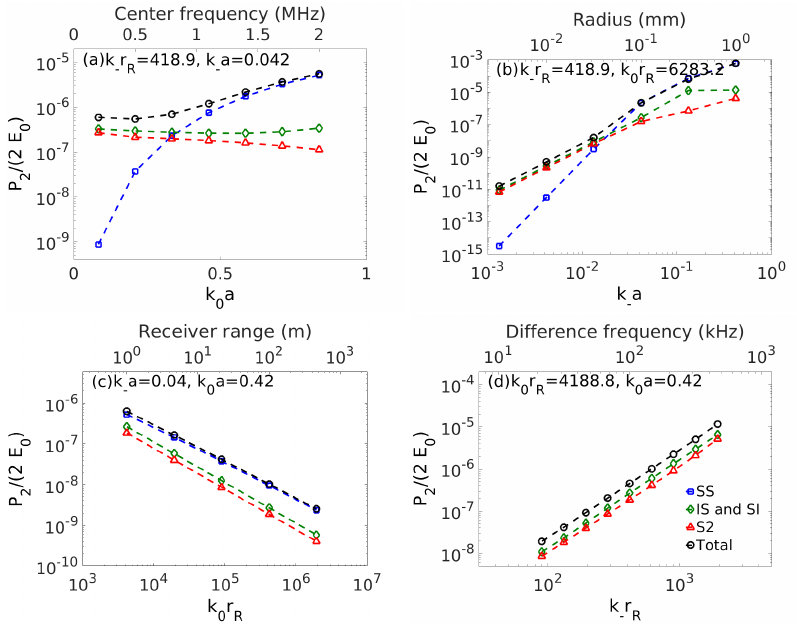
Figure 5. A rigid immovable sphere with perpendicular incident waves propagating at ˆ i x and ˆ i z direction, respectively. The difference frequency component of p 2 is calculated at r R = − r R ( ˆ i x + √ ˆ i 2 as a function of ( a ) center frequency or k 0 a , ( b ) object radius or k − a , ( c ) receiver range or k 0 r R , z ) / and ( d ) difference frequency or k − r R . Lower dimensionless abscissas are for general interpretations. Upper abscissas are for a medical sensing or underwater example of perpendicular primary waves with 1 MHz primary and 100 kHz difference frequencies, sphere radius of 0.1 mm at range 1 m from the receiver with sound speed 1500 m/s sound speed. In ( a ), p SS dominates for large k 0 a , while p IS + p SI and p S2 dominate for small k 0 a . In ( b ), p SS dominates for large k − a , p IS + p SI and p S2 dominate for small k − a . In ( c ), p SS is dominant and has the most gradual roll-off with range. In ( d ), p S2 and p IS + p SI dominate and SS is too small to be shown but appears in Figures S13 or S18. The nonlinear parameter is β =